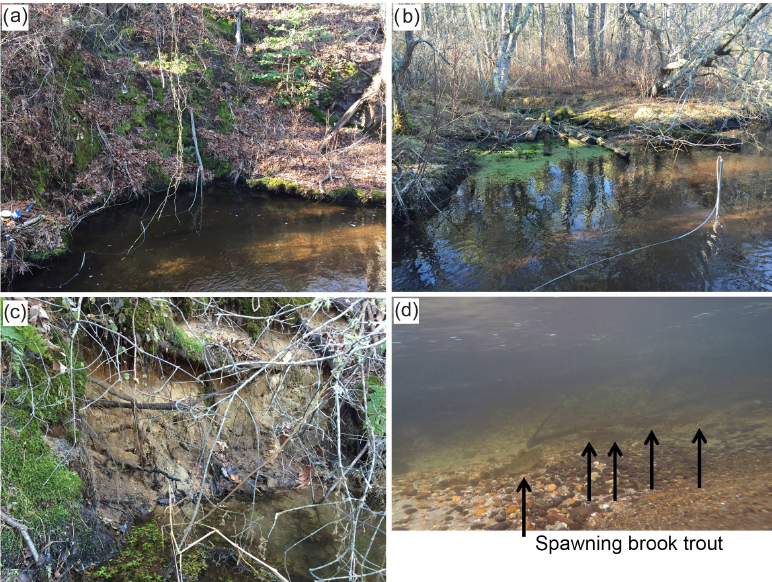
Figure 3. Several representative images of specific spawn zones and groundwater-discharge zones were collected in February 2016. The cutbank alcove at Spawn 1 is shown in (a) , while the open-valley seepage zone GW1045 is shown in (b) , and fresh cutbank slumping and visible seepage at Spawn 3 is shown in (c) . Underwater imagery collected at the Spawn 1 zone in fall 2015 is displayed in (d) , showing several fish clustered directly at the base of the cutbank where pore-water samples were